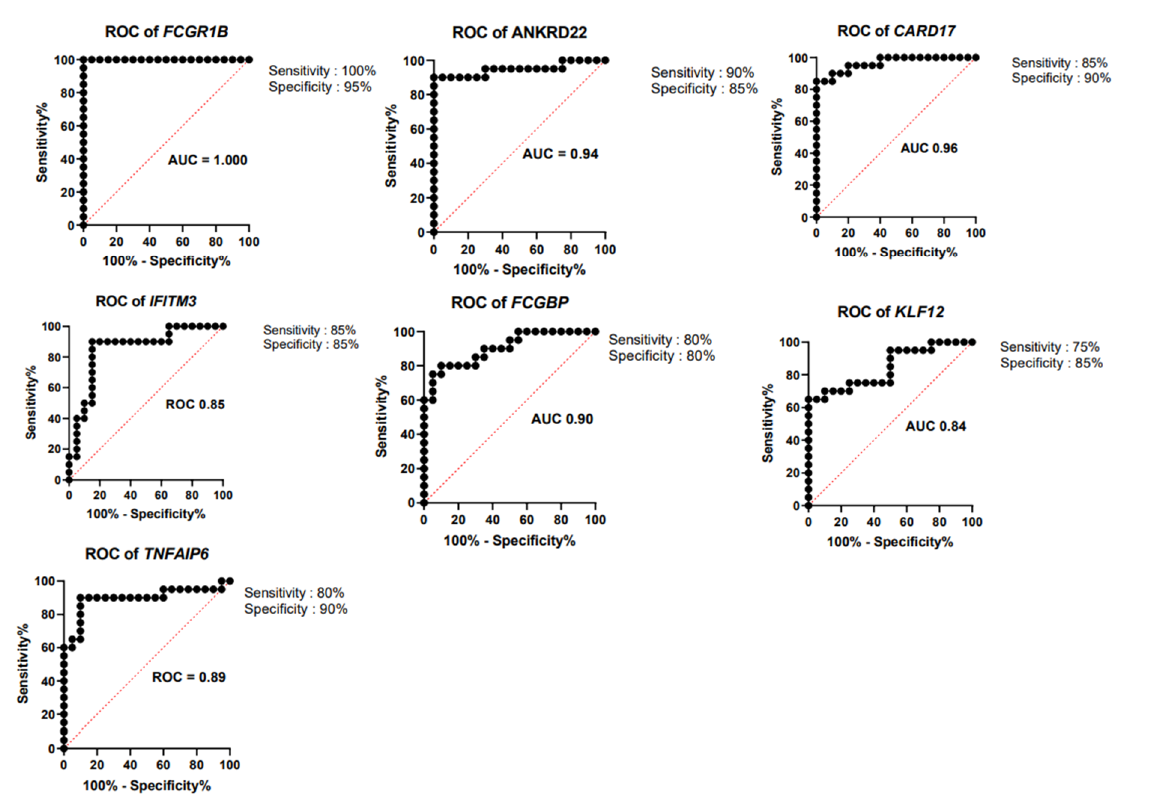
Figure 4. Receiver operating characteristic curve (ROC) analysis. ROC curves for upregulated genes FCGR1B, ANKRD22, CARD17, IFITM3, and TNFAIP6 and downregulated genes FCGBP and KLF12. The seven-gene signature included five upregulated genes ANKRD22 (ankyrin repeat domain containing protein 22), CARD17 (caspase recruitment domain containing protein 17), IFITM3 (interferon-induced transmembrane protein 3), TNFAIP6 (TNF α Induced